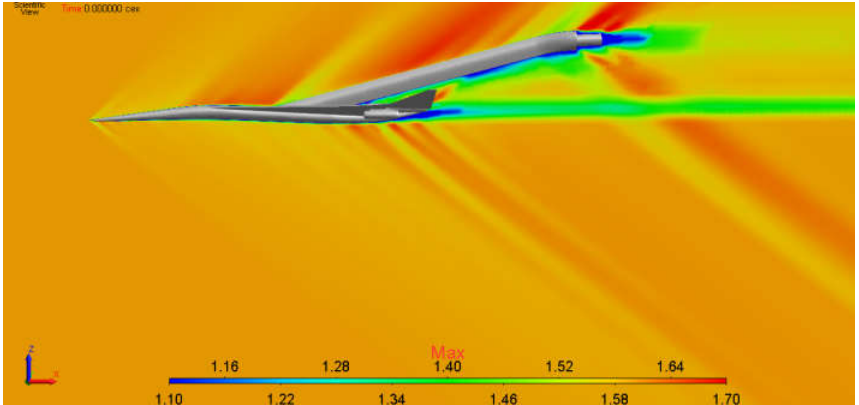
Figure 21. Mach number field, initialization (LM1021).